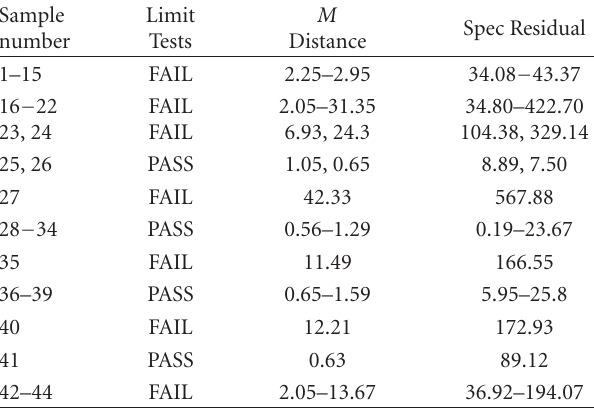
Table 2: Discriminate analysis with normal and malignant standard set.